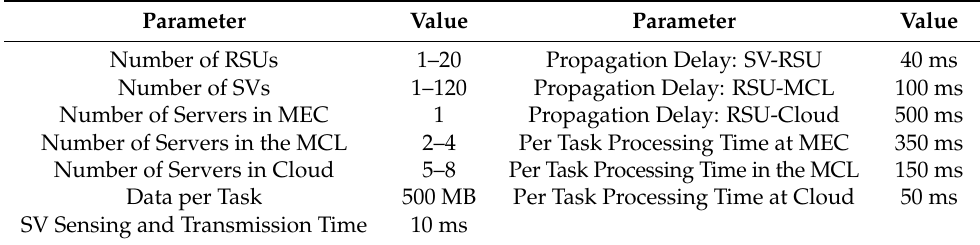
Table 4. Analysis parameters used for comparing the moisture computing layer (MCL), cloud computing, and mobile edge computing architecture; ms = milliseconds, MB =